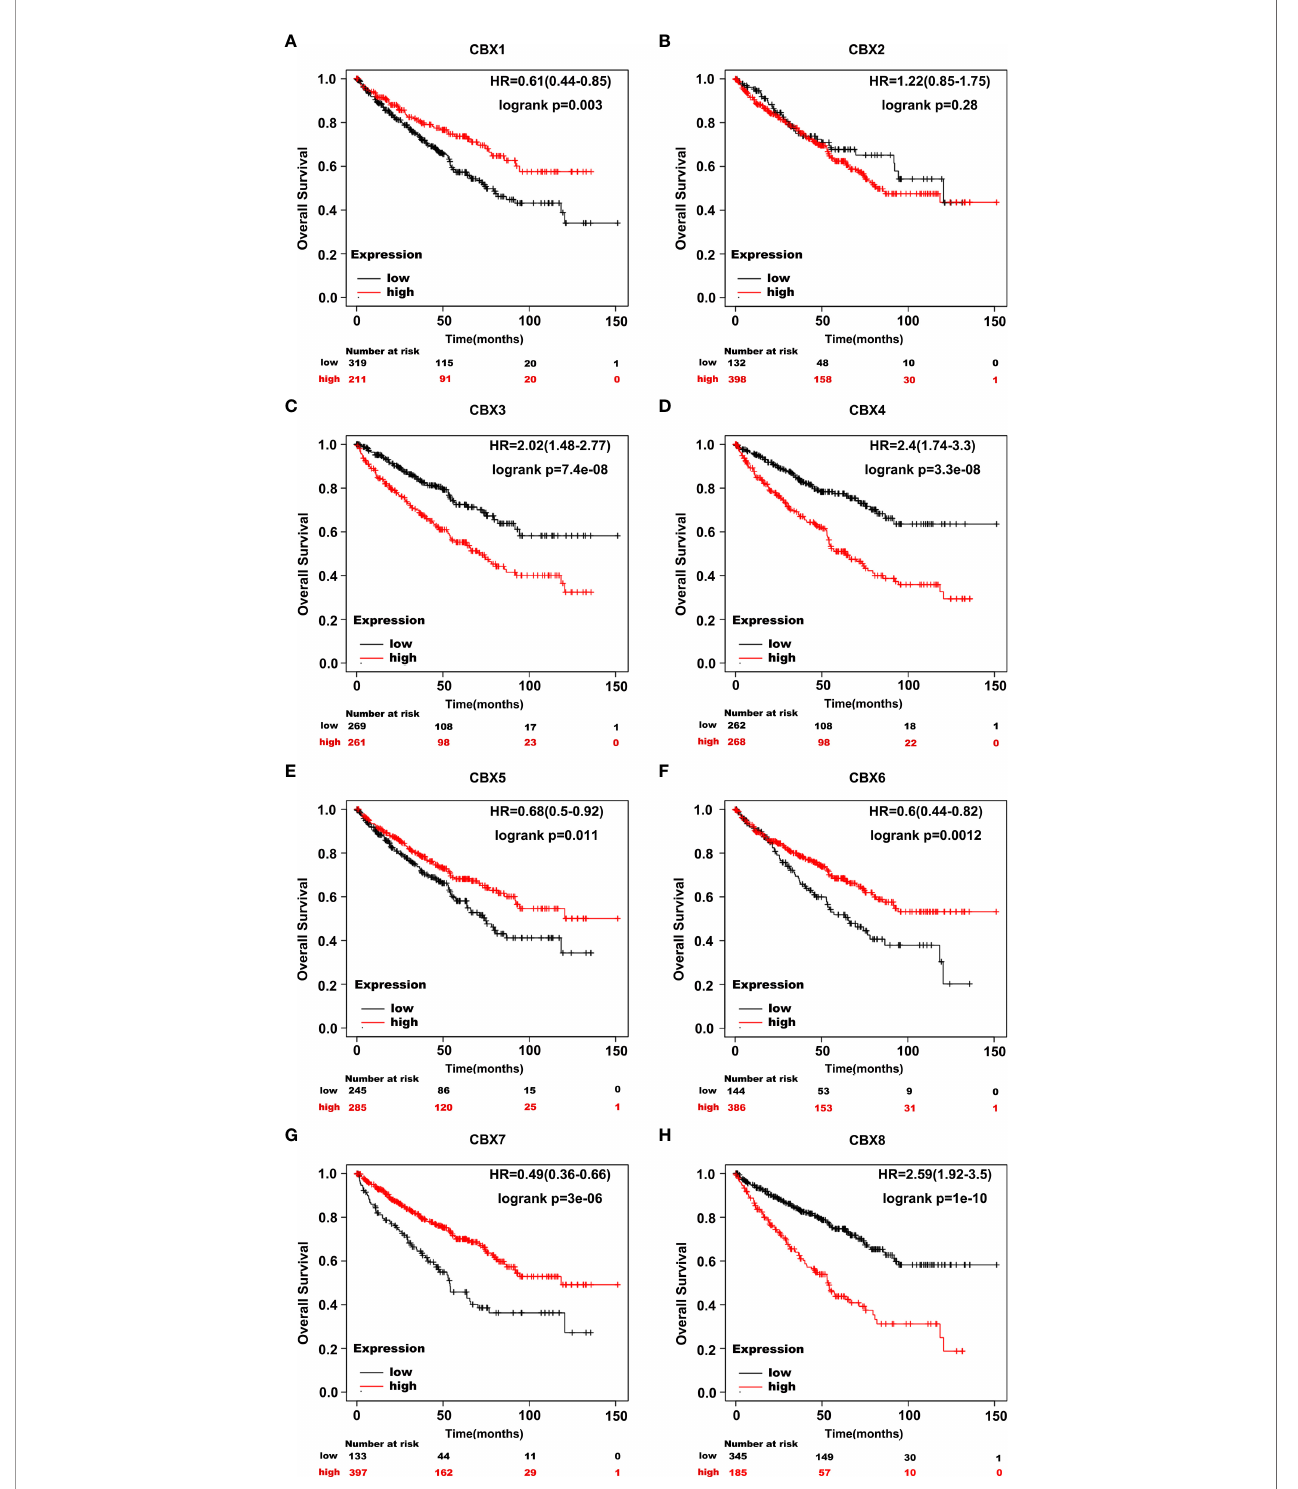
FIGURE 10 | The prognostic value of CBXs in ccRCC patients in the OS curve (Kaplan-Meier Plotter). ccRCC patients with high expression levels of CBX3, CBX4, CBX8 (C, D, H) , and low expression levels of CBX1, CBX5, CBX6, CBX7 (A, E – G) were strongly associated with poor overall survival. However, CBX2 expression showed no correlation with overall survival in ccRCC patients (B)